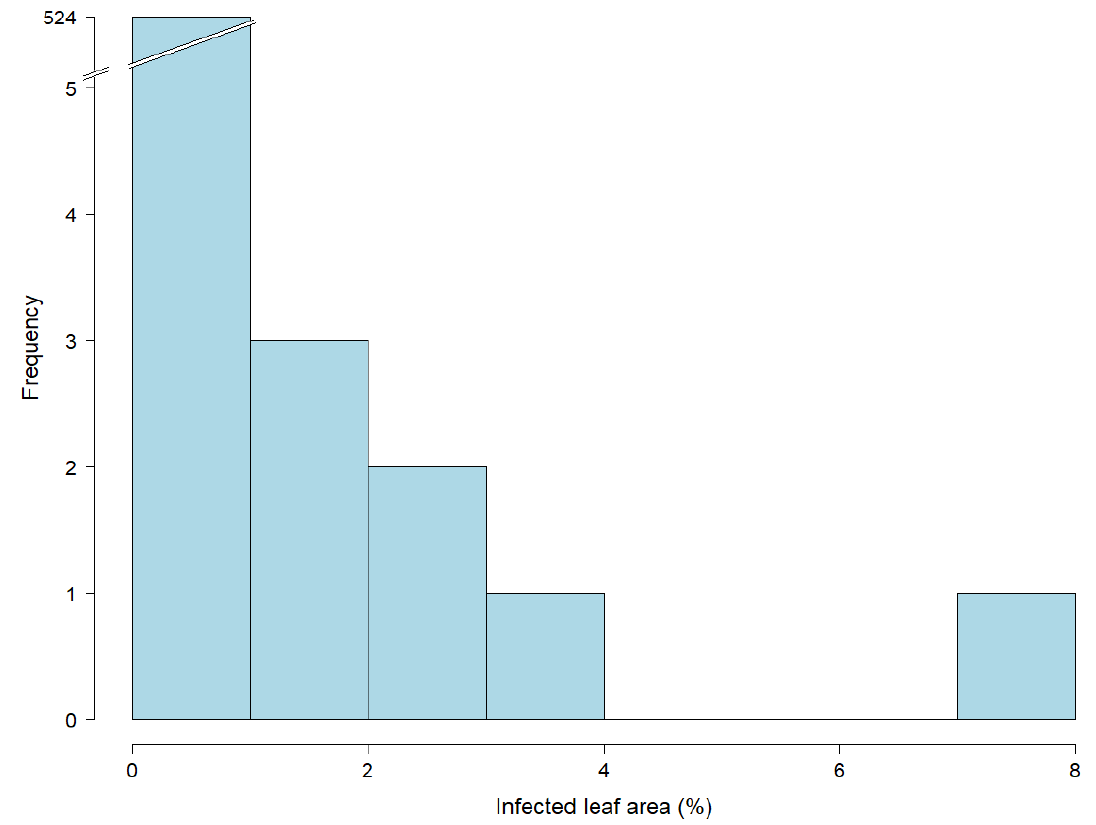
Figure 3. Histogram showing the distribution of leaf rust infections based on 532 leaf samples of 15-week old greenhouse plants (EC 32). Percentage of infected leaf area was determined by an automated phenotyping platform using image analysis. Due to the low infection rates (see the truncated bar of the histogram), data of this developmental stage were excluded from statistical analysis.